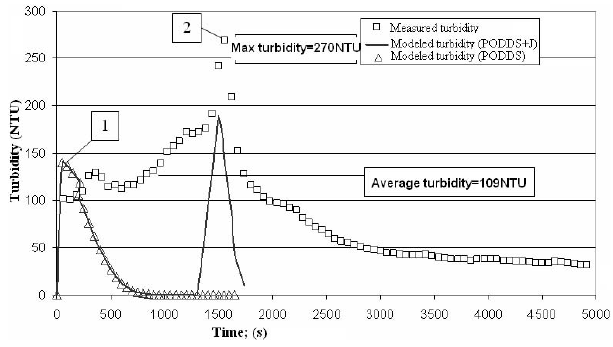
Figure 9. Turbidity curve for flushing site 2 containing two 90 ◦